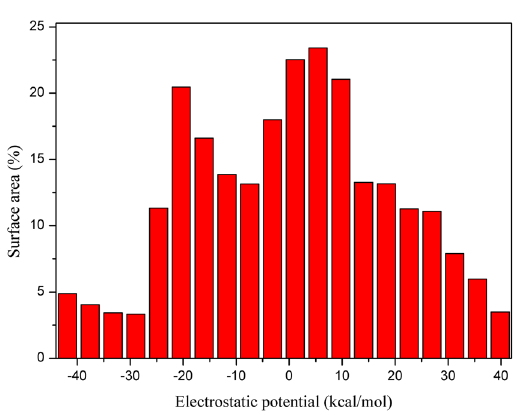
Figure 10. The ESP quantitive distribution column diagram: the X-axis serves as the Surface Area ratio (%), the Y-axis serves as the ESP regions